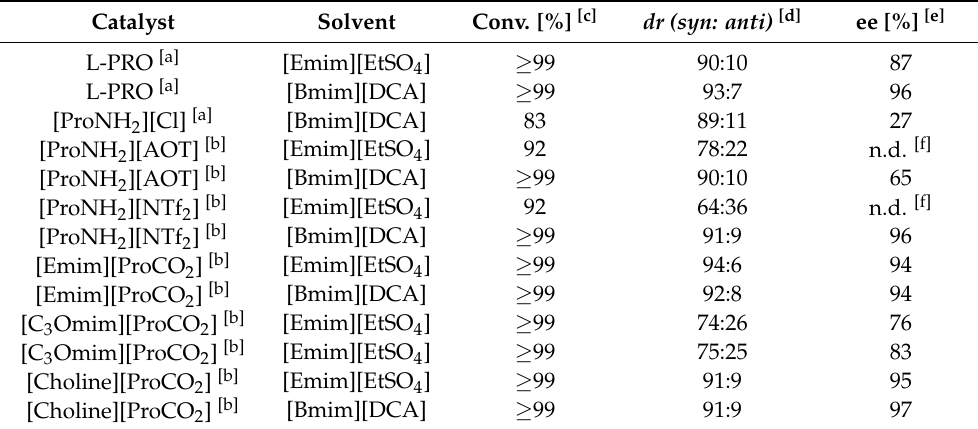
[a] Reaction time: 66 h. [b] Reaction time: 90 h. [c] The conversions were determined using 400.13 MHz 1 H NMR spectroscopy. [d] The ratio of the percentage of one diastereoisomer in a mixture to that of the other was determined from 400.13 MHz 1 H NMR spectroscopy. [e] Enantiomeric excess and the ratio of the percent of one enantiomer (syn) in a mixture to that of the other were determined by HPLC using Phenomenex Lux 5 µ m